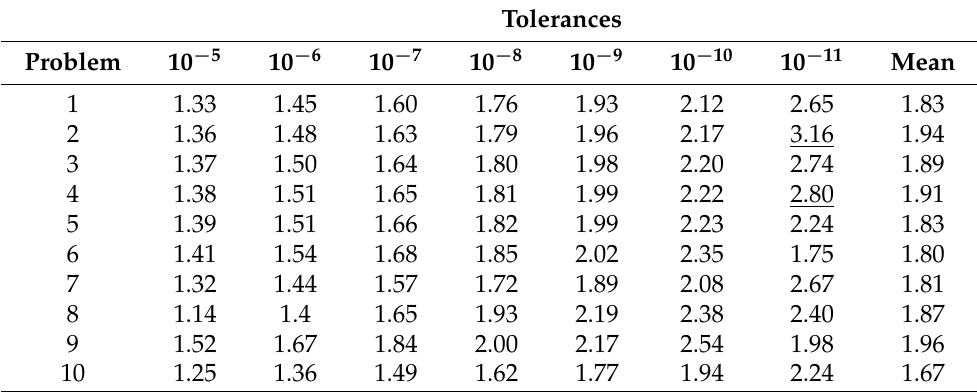
Table 2. Efficiency measures ratios of DP5(4) vs. NEW5(4) over the interval [ 0,10 π ] .